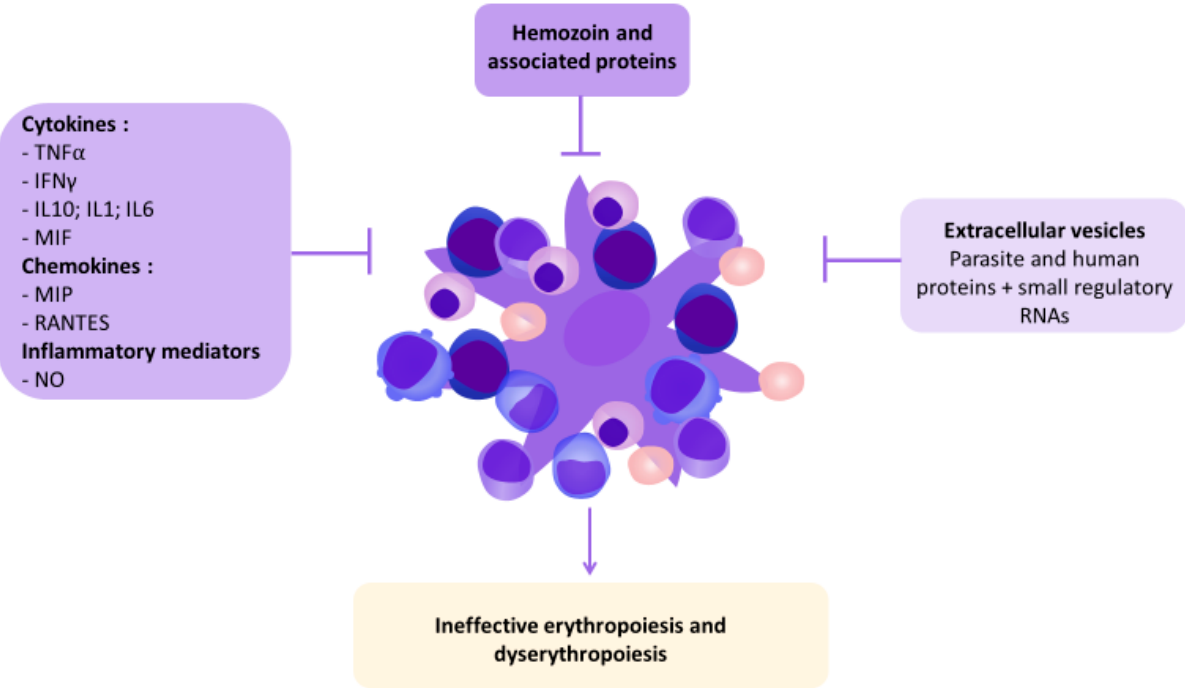
Figure 2. Human and parasite factors affecting erythropoiesis in